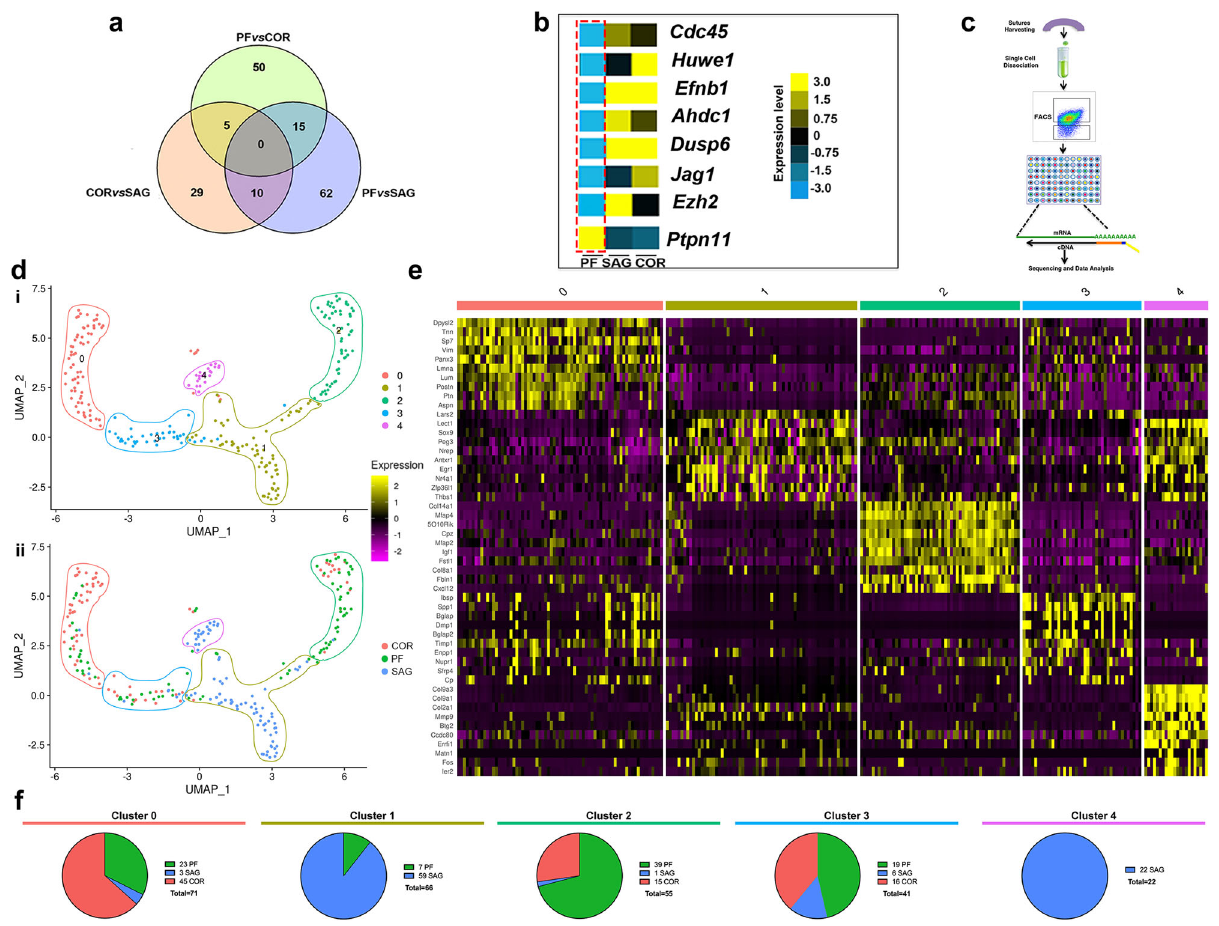
Fig. 2 Transcriptomic pro fi ling of CD51 + ;CD200 + cells from fusing and non-fusing sutures. a Venn diagram of top differentially expressed genes (up- or downregulated by ≥ 3 fold) from bulk RNA-seq evaluation of skeletal stem/progenitor cells (CD51 + ;CD200 + ) isolated from different sutures. b Heatmap representation of top genes associated with syndromic craniosynostosis in CD51 + ;CD200 + cells isolated from PF sutures 37 – 43 . Yellow: upregulation; blue: downregulation. c Schematic outlining single-cell RNA analysis. d UMAP embedding showing the distribution of transcriptional programs for single CD51 + ; CD200 + cells isolated from PF, SAG, and COR sutures partitioned into fi ve clusters. Cells are colored either by cluster ( i ) or suture of origin ( ii ). e Heat map of top 10 differentially expressed genes characteristic to each of the fi ve transcriptionally-de fi ned clusters. Yellow: upregulation; purple: downregulation. f Pie chart showing the representation of CD51 + ;CD200 + cells from each suture within each cluster. Sequencing data were deposited in the GEO database as GSE69909. All data can be accessed from the Gene Expressions Omnibus (http://www.ncbi.nlm.nih.gov/geo/) using accession number GSE138882. PF posterior frontal, SAG sagittal, COR